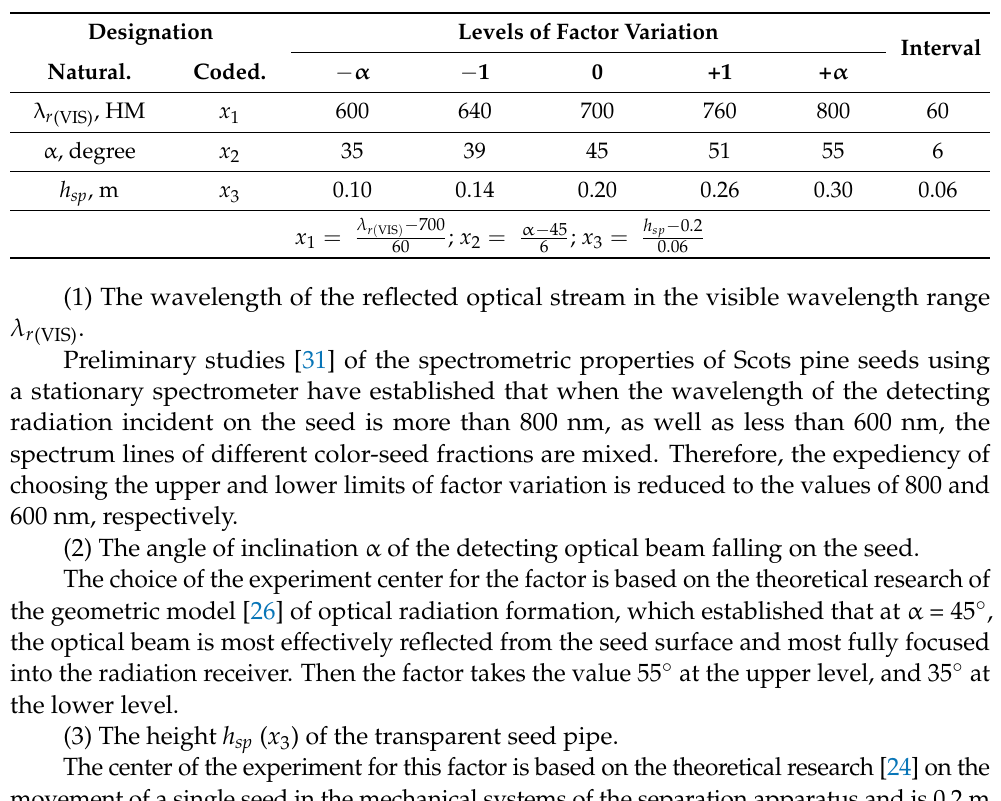
Table 2. Values of factors and levels of their variation in the implementation of a uniform rotat- able plan.